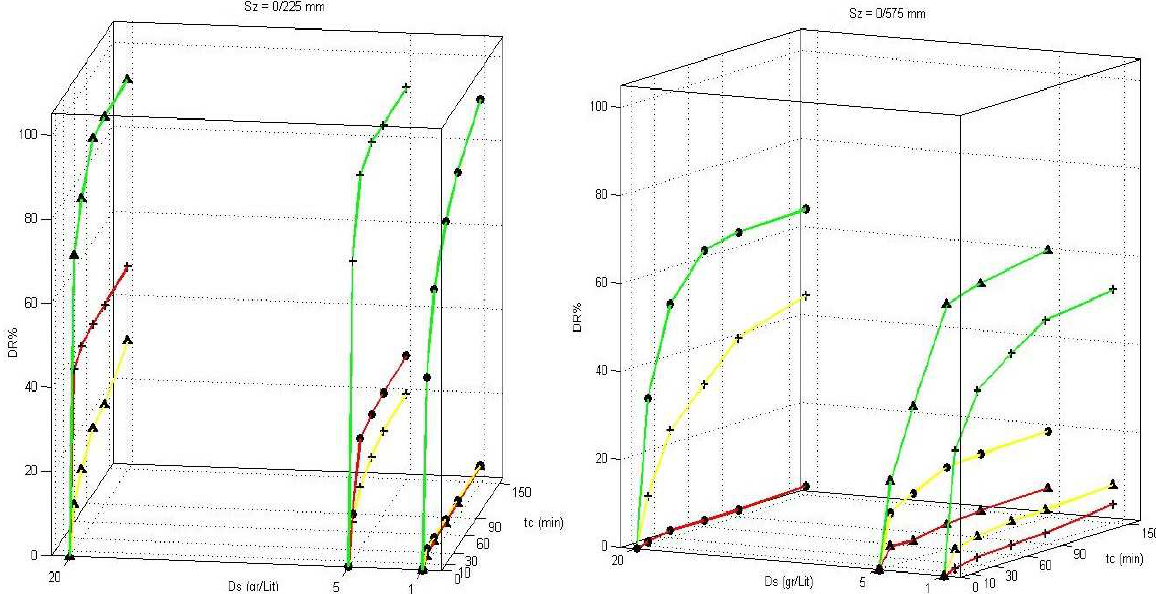
Figure 1. Ninety dye removal (DR%) of all 18 runs, green line (pH0 = 3), yellow line (pH0 = 7), red line (pH0 = 11), circle marker (C0 = 10 mg/l), plus sign marker (C0 = 50 mg/l), triangle marker (C0 = 100